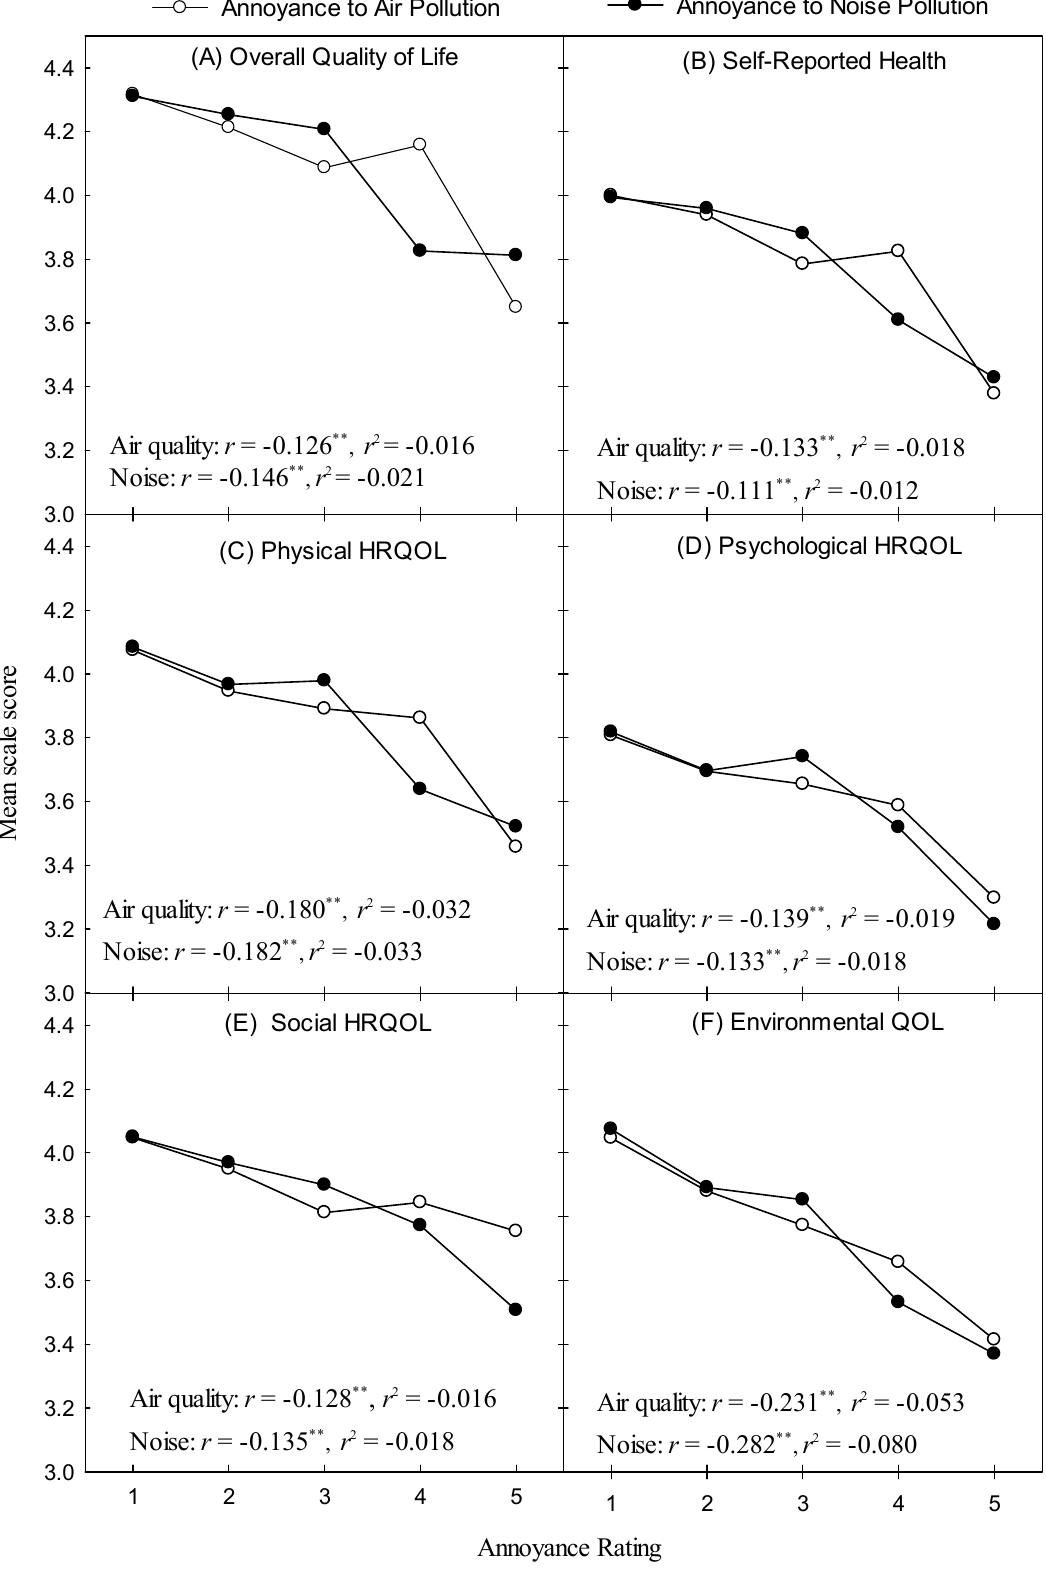
Figure 3. Plots of mean scale scores for outcome variables of interest versus air quality (open symbols) and noise annoyance (closed symbols). Each panel represents an aspect of HRQOL or self-reported health (Panel B). Asterisks indicate statistically significant differences (** p < 0.001).